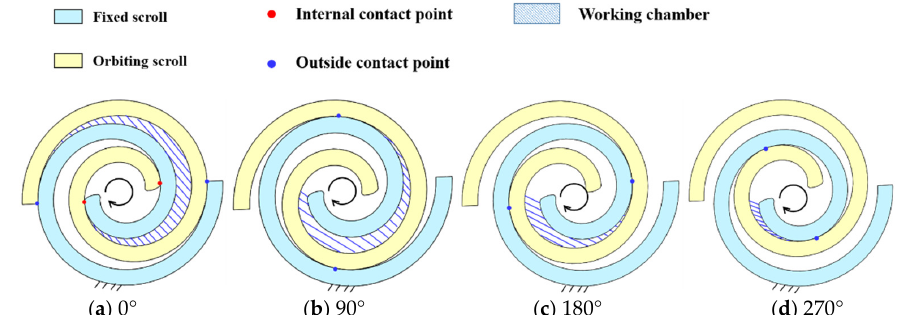
Figure 1. Working principle of scroll pump.